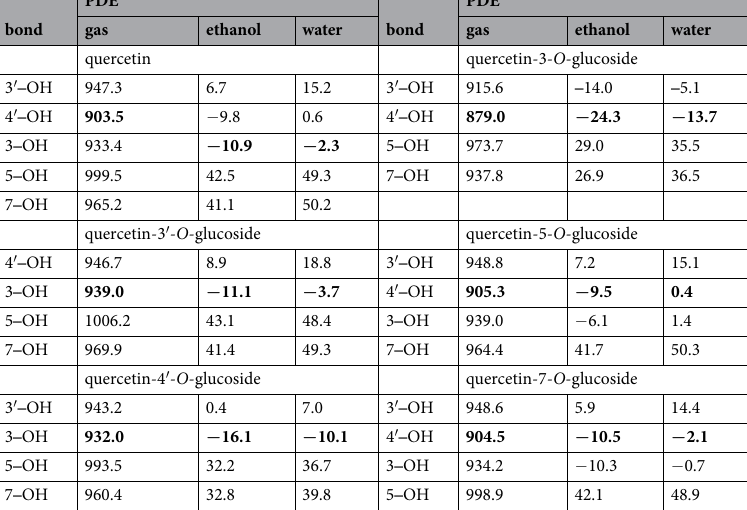
Table 4. Proton dissociation enthalpies (PDE) in kJ/mol obtained at M062X/6–311 + G ** level of